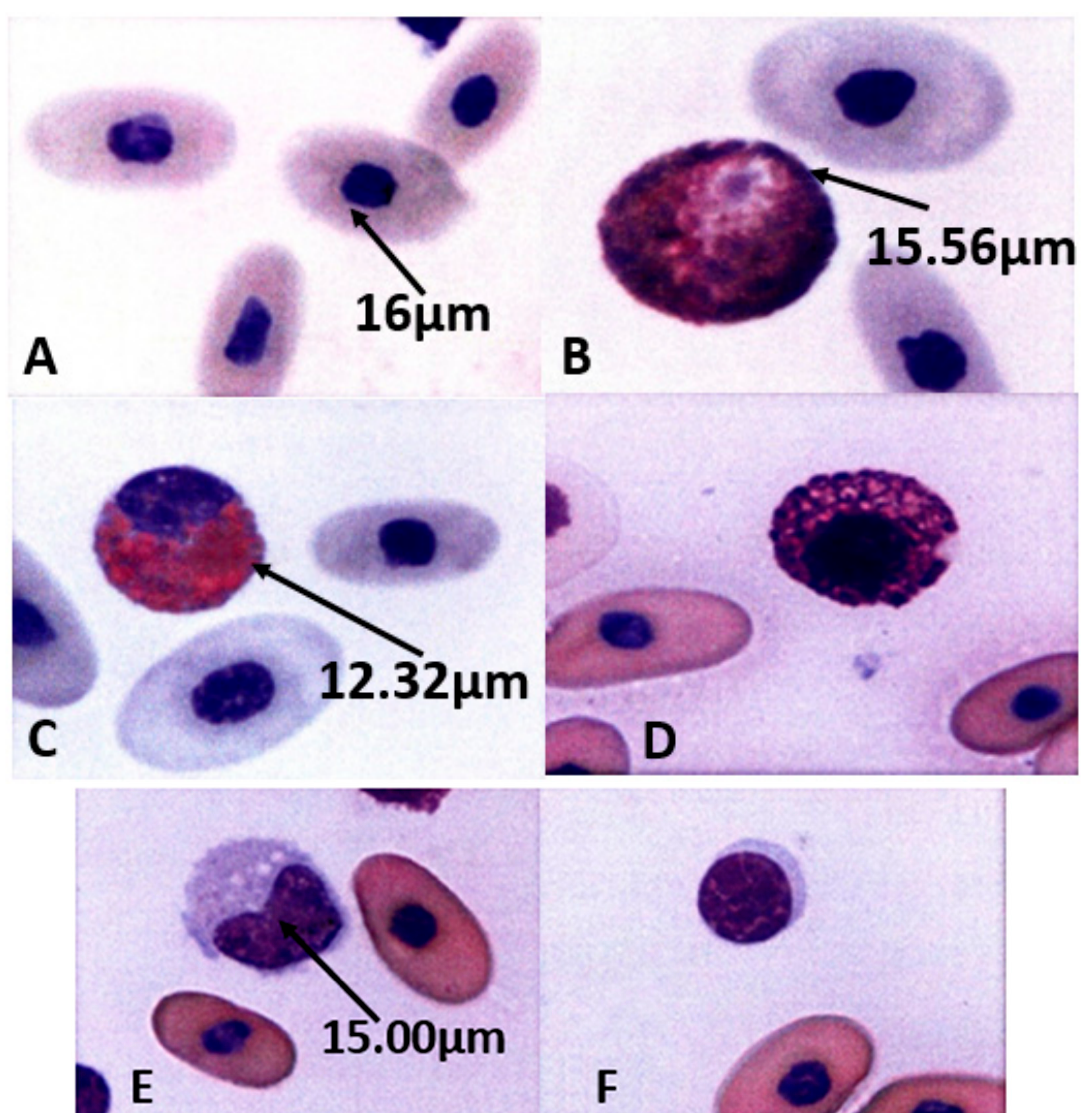
Figure 3. Morphology of peripheral blood cells of captive false gharial. ( A ): Showing erythrocytes of Tomistoma schlegelii, observed cells were ellipsoidal and homogenous in color, size, and shape, with centrally positioned oval dense round nuclei. ( × 100). ( B ): Showing heterophils of T. schlegelii , which are the largest and the most common leukocytes in the peripheral blood. Observed cells were large, with a characteristic fusiform acidophilic cytoplasmic granule and a round to ovule shape with an eccentric nucleus. ( × 100). ( C ): Showing eosinophils of T. schlegelii , observed cells were large with a round to spherical eosinophilic cytoplasmic granule. The nuclei are variable in shape, and could be slightly elongated, to lobulated with coarse, clumped chromatin that stains purple. ( × 100). ( D ): Showing basophils of T. schlegelii , observed cells were spherical and filled with basophilic metachromatic granules. The nuclei were slightly eccentric and obscured by the cytoplasmic granules. ( × 100). ( E ): Showing monocytes of T. schlegelii , observed cells had a variable shaped nucleus that varied from oval to irregular, with a finely granular and often vacuolated cytoplasm. ( × 100). ( F ): Showing lymphocytes of T. schlegelii , observed cells had a round or slightly indented nucleus and basophilic cytoplasm. The eccentrically positioned and nuclear chromatin was heavily clumped. ( ×